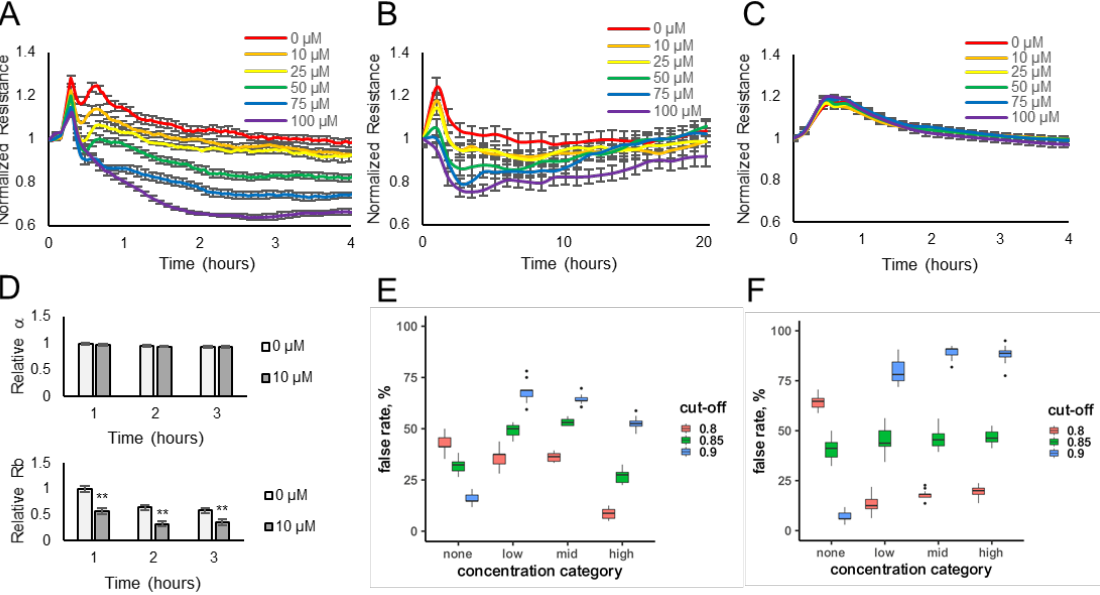
Figure 1. Lyral exposure causes a transient dose-dependent decrease in cellular resistance. HUVEC monolayers (expressing the OR10J5 receptor) were exposed to different concentrations of lyral (10–100 µ M), and resistance was monitored over a 4 h ( A ) or 20 h ( B ) period. ( C ) HaCaT monolayers (not expressing the OR10J5 receptor) were exposed to different concentrations of lyral (10–100 µ M), and resistance was monitored over a 4 h period. Resistance values (ohms) were normalized to initial readings before odorant addition. Data represented as mean ± SEM of one independent experiment representative of three experimental repeats. ( D ) HUVEC multi-frequency resistance data were modeled to derive parameters, α (basal adhesion) and R b (paracellular barrier), after a 1-, 2-, or 3-h exposure to lyral (0 or 10 μ M). Both α and R b values are represented as relative to initial α and R b values before odorant addition. Data shown as mean ± SEM of 3 independent experiments; ** p < 0.01 as indicated. Statistical model prediction accuracy using the actual resistance data ( E ) or using permuted (randomly rearranged) resistance data ( F ). The x-axes represent the lyral concentration category: none (0 μ M), low (0.1 to 0.5 μ M), medium (1.0 to 10.0 μ M), and high (greater than 10.0 μ M), and the y-axes shows the false rate percentage, reflecting false positive or negative rates depending on the x-axes categories. Samples in the none category but mis-predicted as containing odorant are false positives. Samples in the low, medium, or high category but do not contain odorant are the false negative rate, also plotted on the y-axes.